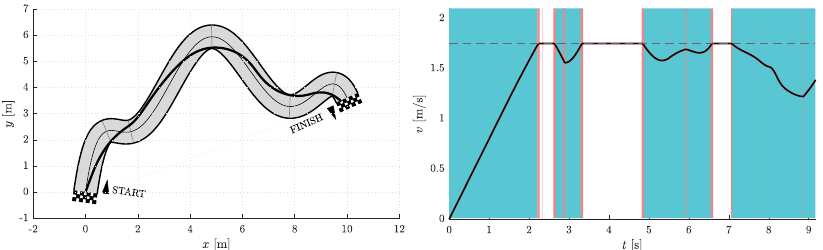
Figure 11. Resulting path as optimization result for N free = 5 and N seg = 3 ( left ) with the corre- sponding velocity profile ( right ). Blue vertical bands indicate intervals where the acceleration reaches its maximum allowable values. Similarly, red vertical bands indicate intervals where the jerk reaches its maximum allowable